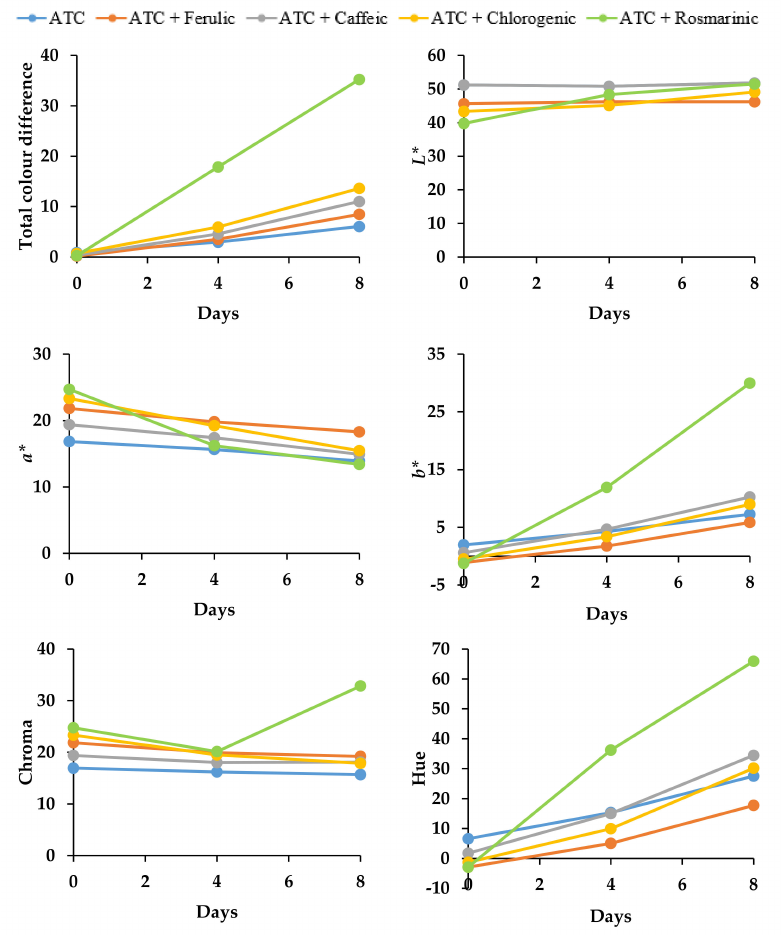
Figure 7. Effect of intermolecular copigmentation on total color difference, L *, a *, b *, chroma, and hue angle during storage at 20 ◦ C in pH 6.0 buffer solutions. *Anthocyanins (ATC); L * (lightness); a * (redness/greenness); b * (yellowness/blueness). After 30 days of storage at pH 3.0 (Table 3a), anthocyanins with chlorogenic acid demonstrated better color retention (~86.3%) ( p < 0.05), indicating higher color stability, with lower total color difference, L* , b *, and hue angle values, as well as higher a * and chroma values (Figure 6), followed by rosmarinic acid (~84.8%) and the control samples (~82.8%). After 90 days, even though chlorogenic acid and the control indicated higher